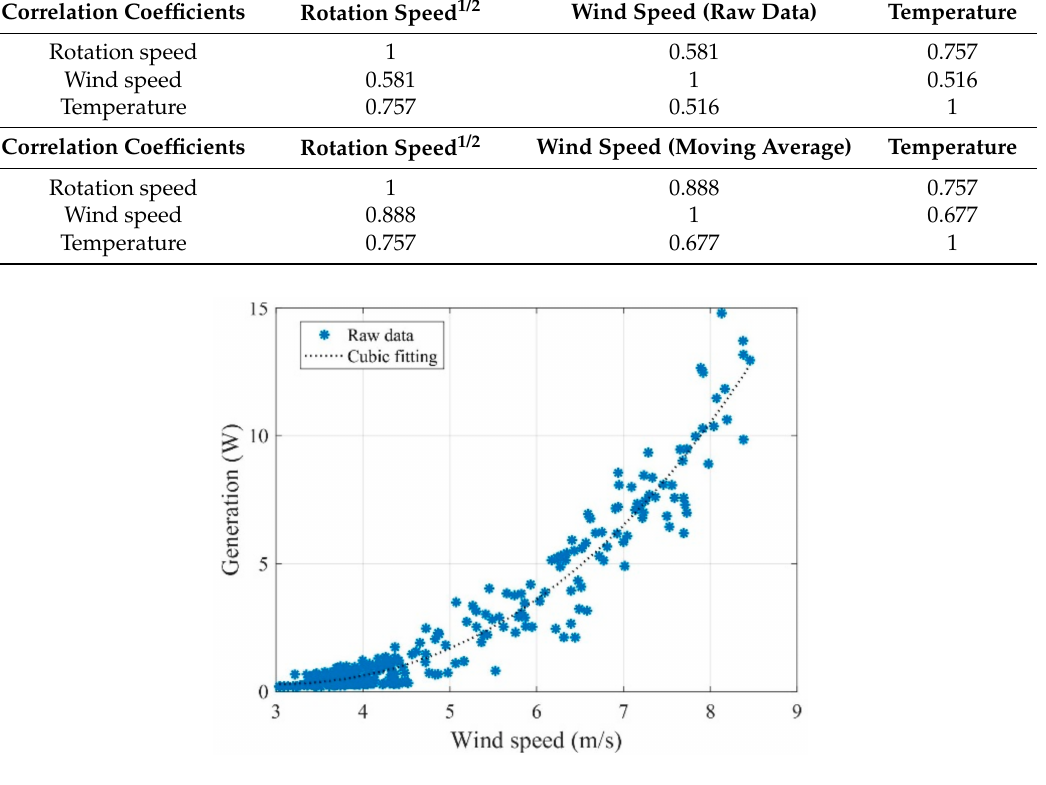
Figure 10. Power curve of the rooftop VAWT on 28 August